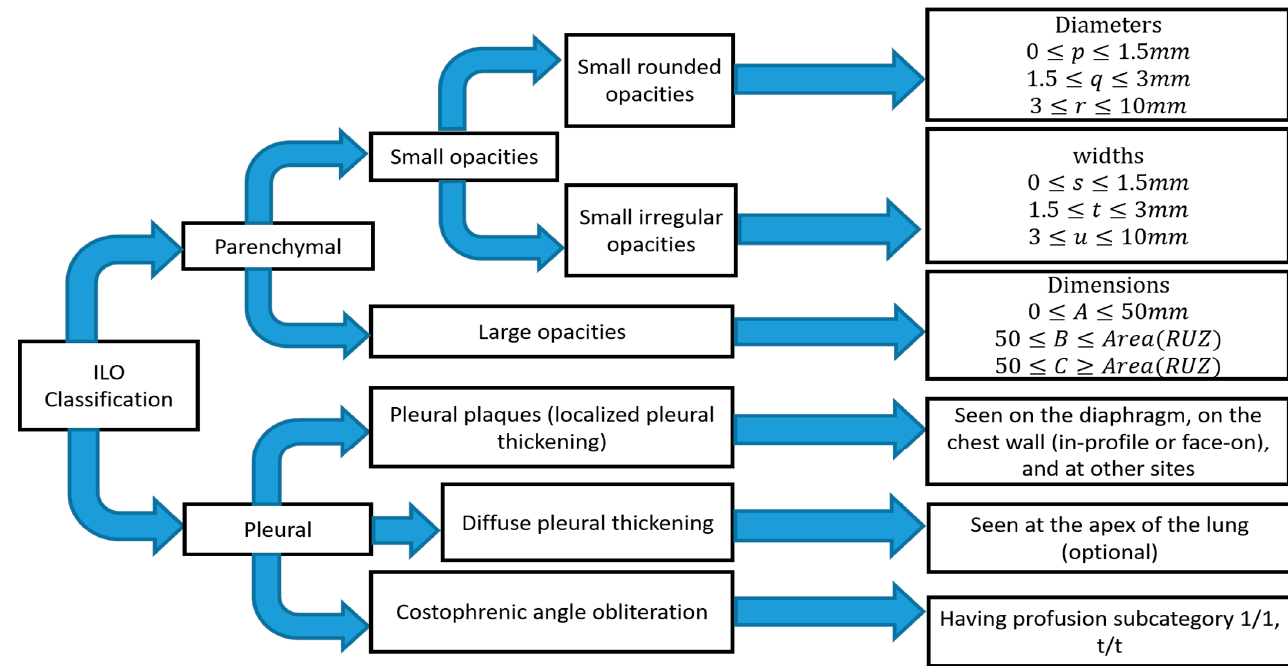
Figure 1. Summary of ILO standard classification of pneumoconiosis.